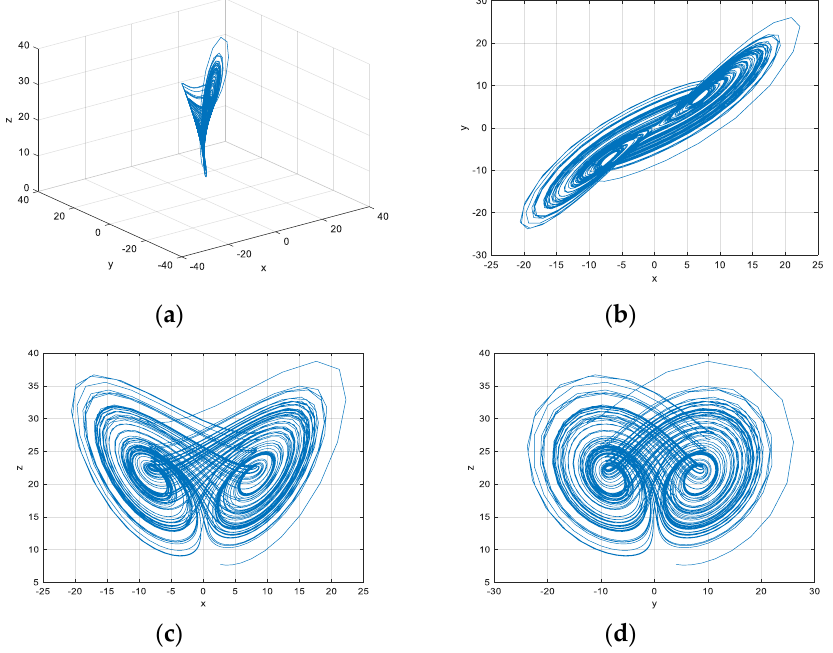
Figure 7. Phase space diagram of each plane when α = 1. ( a ) x-y-z plane; ( b ) x-y plane; ( c ) x-z plane, ( d ) y-z plane.